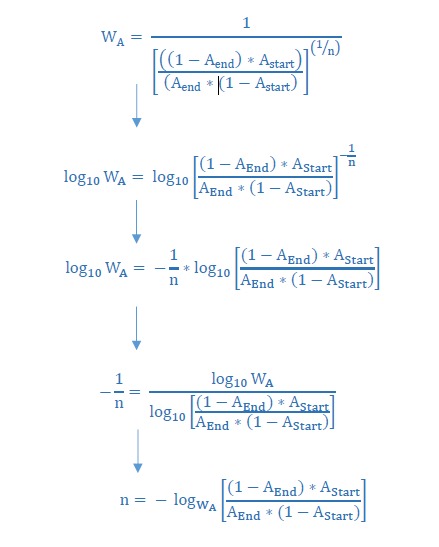
DOI:
http://dx.doi.org/10.7554/eLife.22939.025